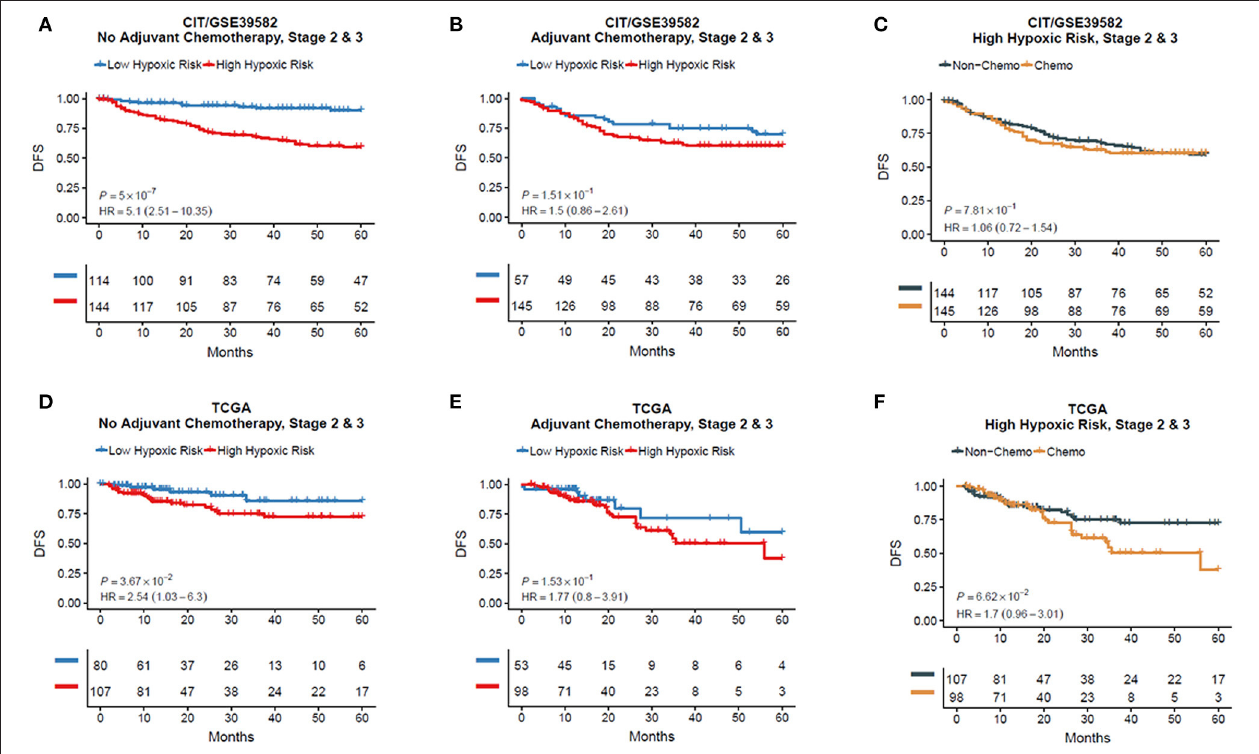
FIGURE 3 | Kaplan–Meier plots for validations of the 12-gene hypoxia signature in chemotherapy and non-chemotherapy cohorts (A–F) .